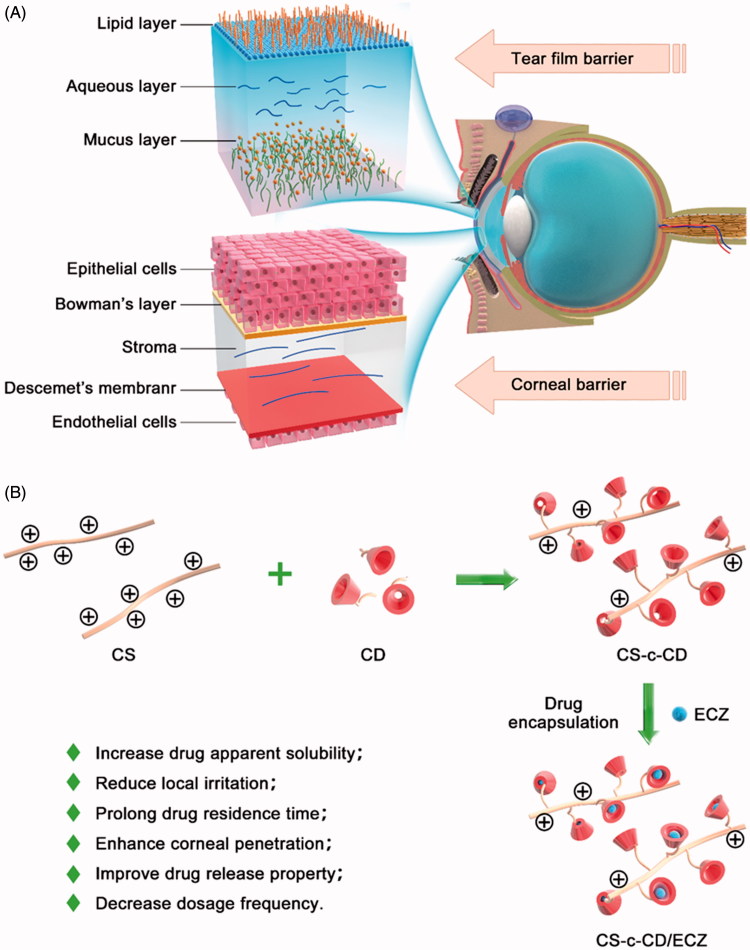
(A) Two major barriers to topical ocular drug delivery. Tear film barrier: a high tear turnover rate and gel-like mucus layer. Corneal barrier: tight junctions in the corneal epithelial cells and alternating polarity five-layer structure. (B) Schematic illustration of vector synthesis, drug loading, and the virtues of NDDS for ocular topical administration.